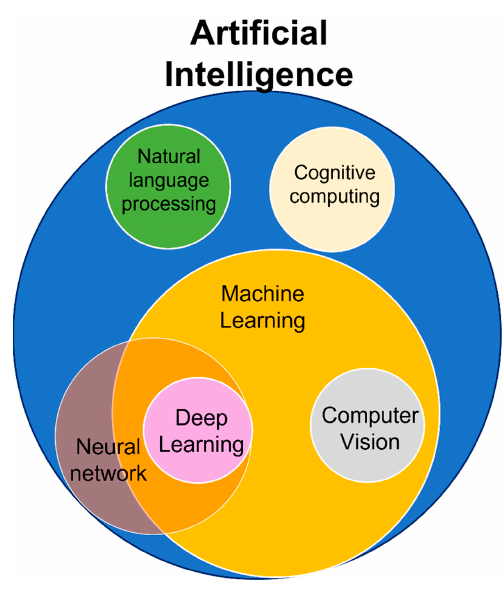
Figure 9. Key Components of AI.